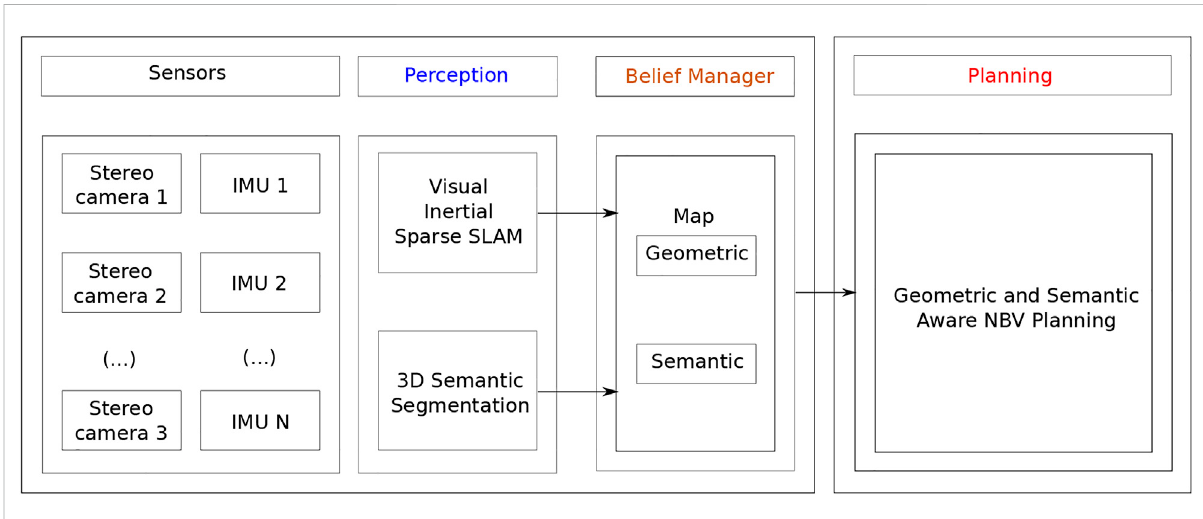
FIGURE 2 Overview of the proposed autonomous navigation system for localization and semantic-metric mapping of shipyard